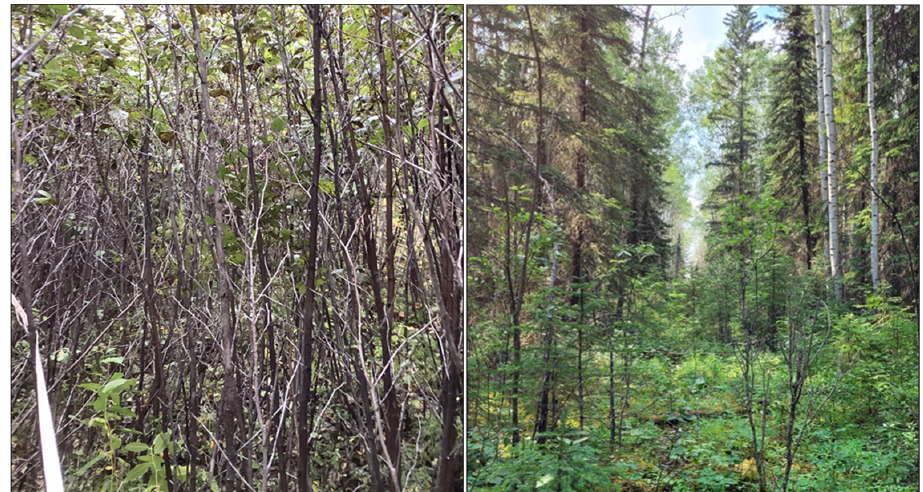
Figure 1. Examples of sampled seismic line areas; the left image shows an area with dense woody vegetation on a cutblock, and the right image shows a sparsely vegetated area in an untreated